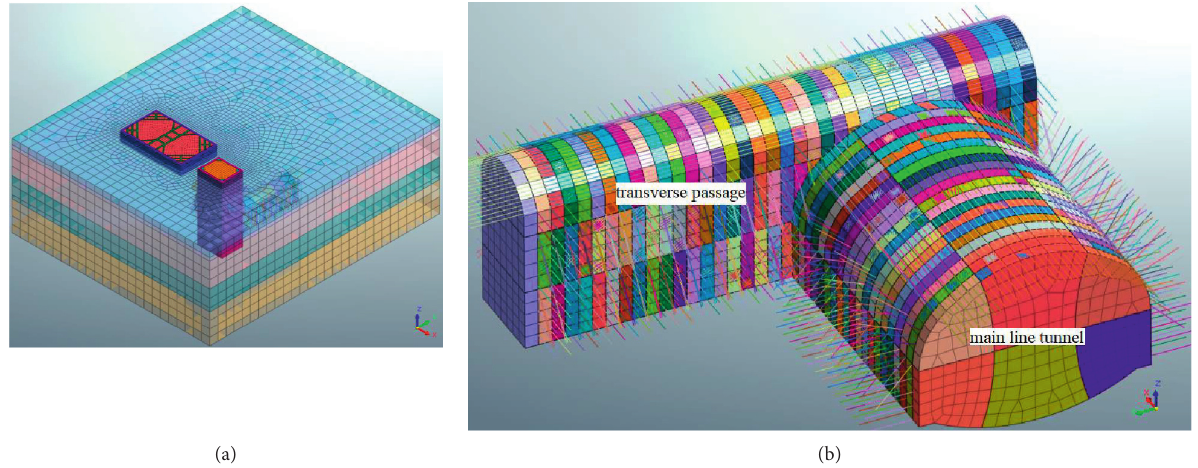
Figure 3: Double-side heading method model. (a) Overall model. (b) Main tunnel